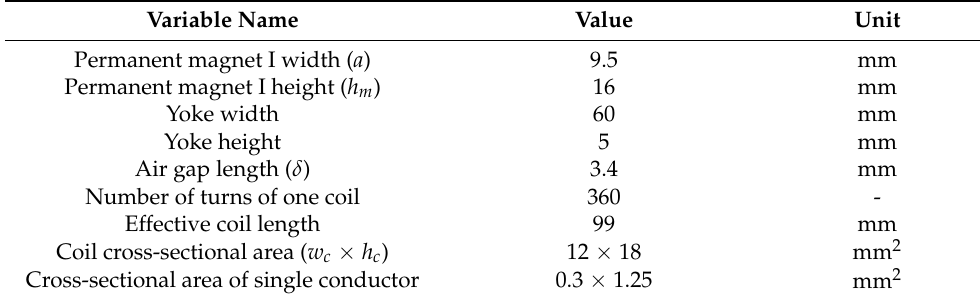
Table 1. Main parameters of the linear voice coil motor.